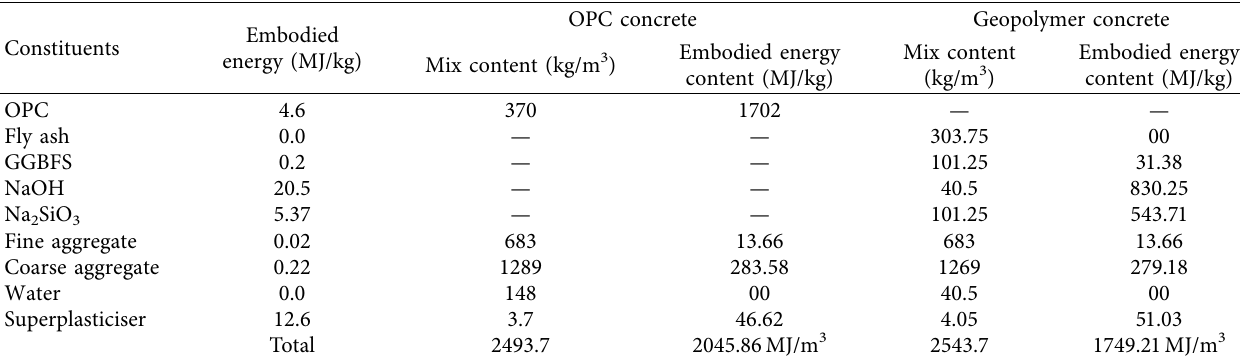
Table 3: Embodied energy calculation of GPC and